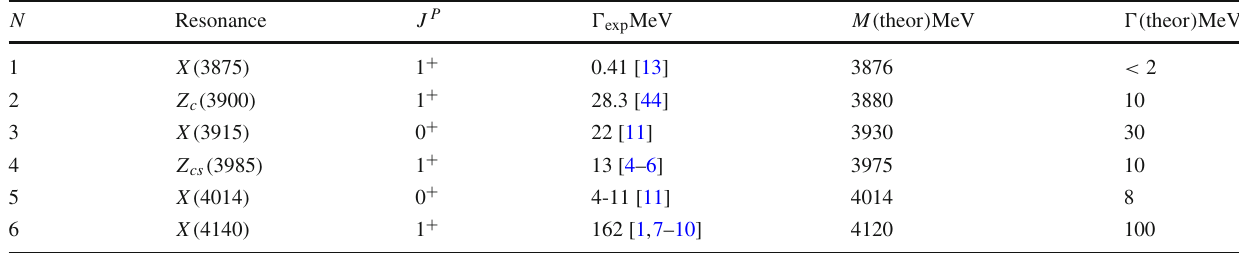
Table 7 The ERM results for the resonances of the Set A in comparison with experiment N Resonance J P